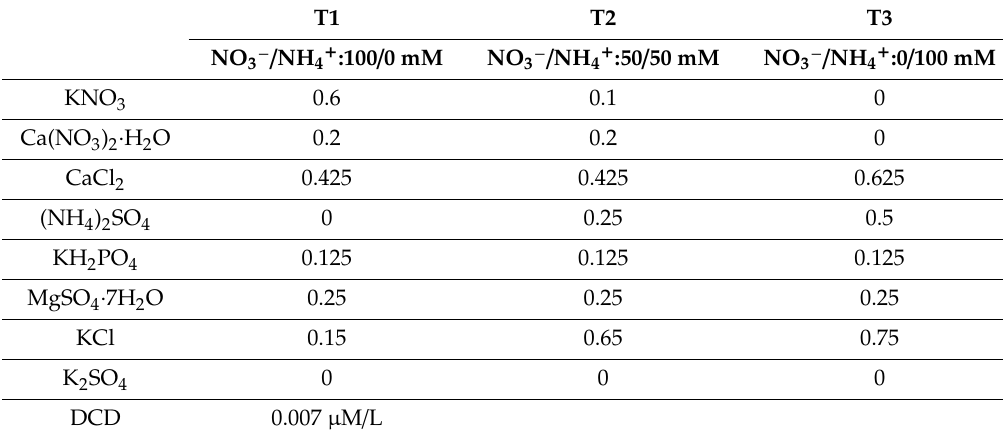
Table 3. Composition of the nutrient solution in the three